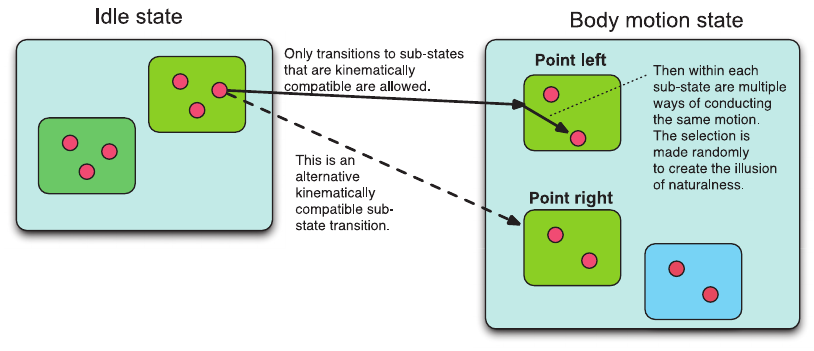
Figure 13. Semideterministic Hierarchical Finite-State